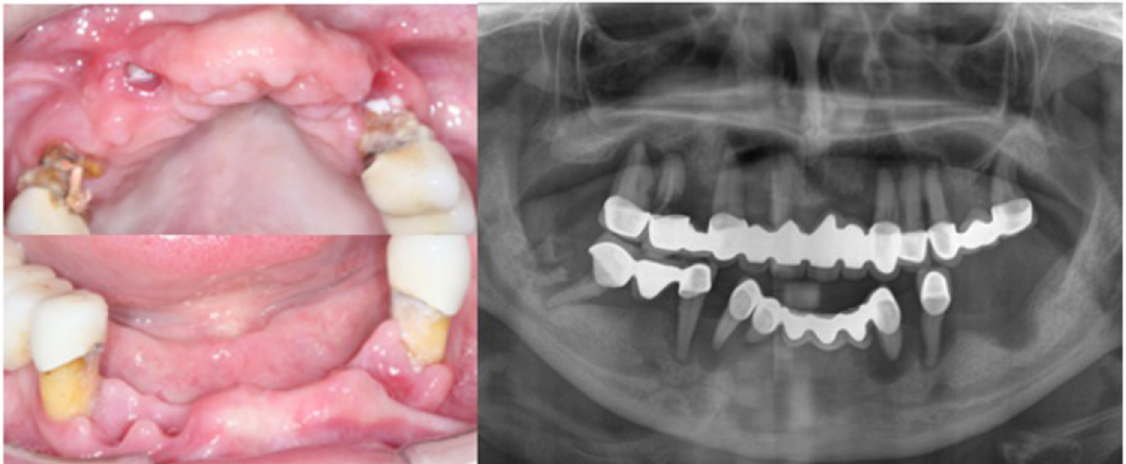
Fig 5. Pre-operative views. Initial intra-oral upper and lower jaw (right) and the initial panoramic x-ray (left).